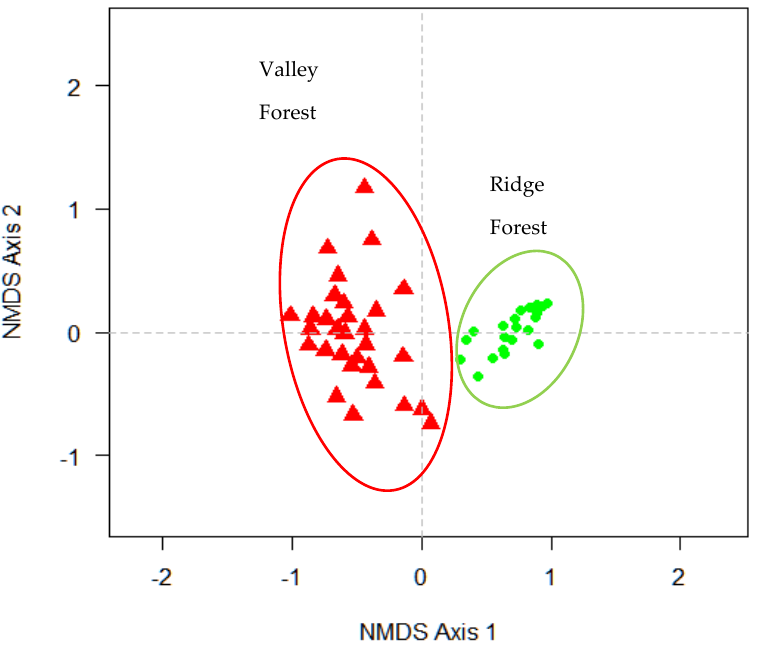
Figure 2. Non-metric multidimensional scaling analysis of species composition for the samples (plots).